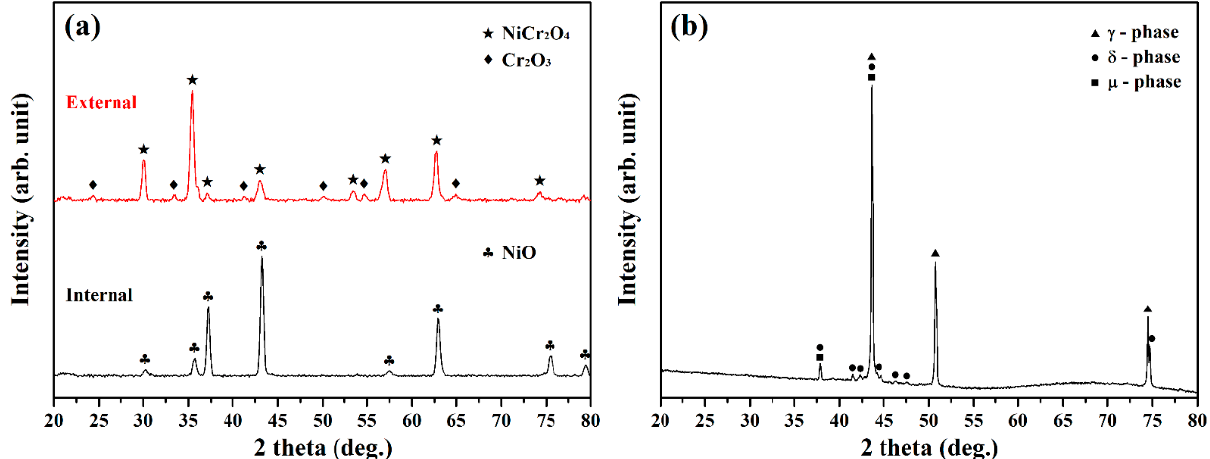
Figure 5. XRD patterns of the ( a ) external and internal surfaces and ( b ) substrate of the ruptured C-276 pipe.